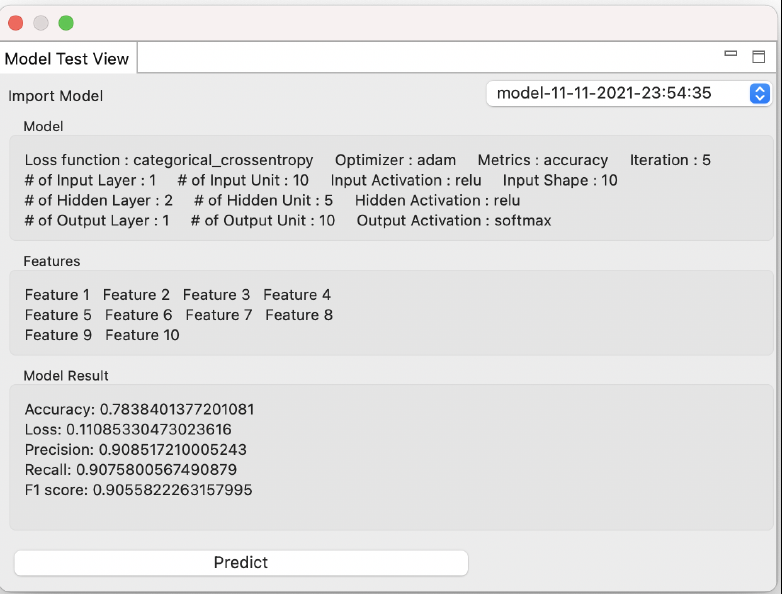
Figure 7. The tool screenshot of Model Test View